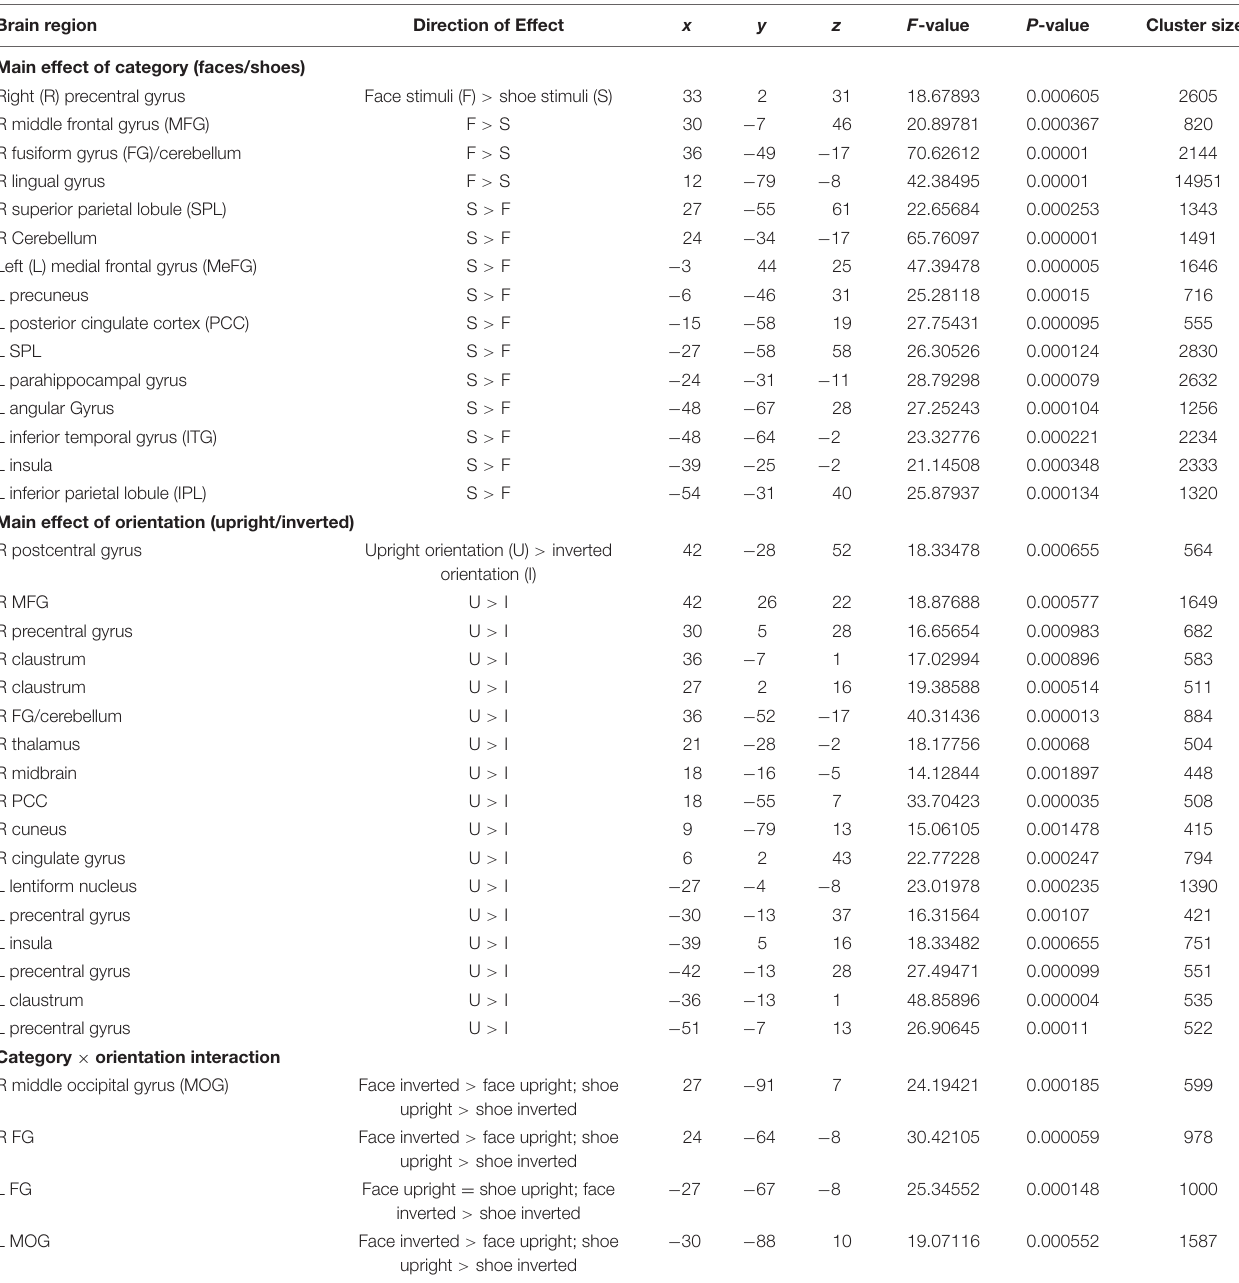
TABLE 1 | Results from 2 × 2 repeated measures RFX ANOVA. Brain